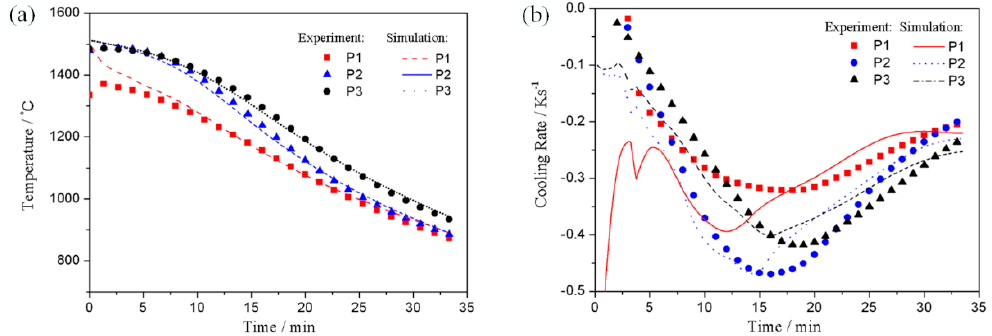
Figure 3. Comparison of temperature and cooling rate curves from experiment and simulation: ( a ) temperature change with time and ( b ) cooling rate curve.